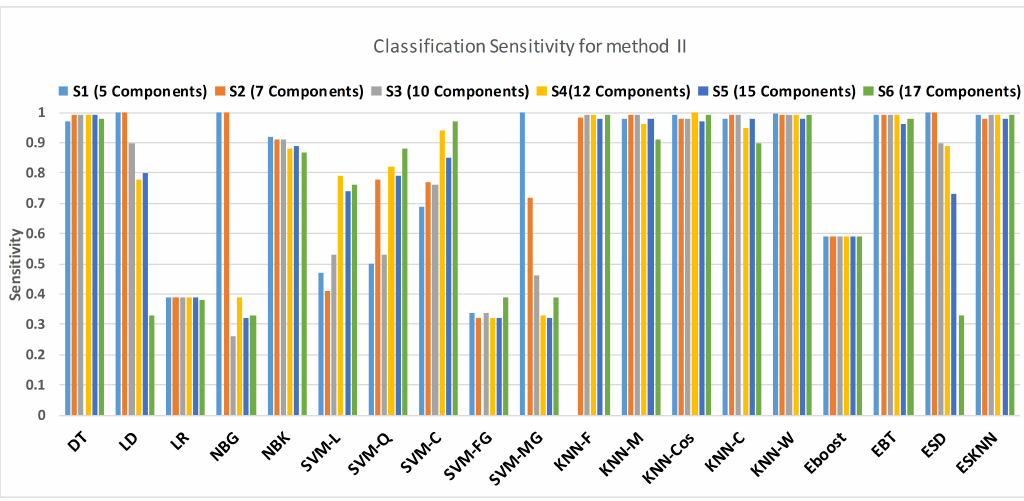
Figure 15. Performance of accuracy for different feature sets in various classifiers for PuPG signal through method II.